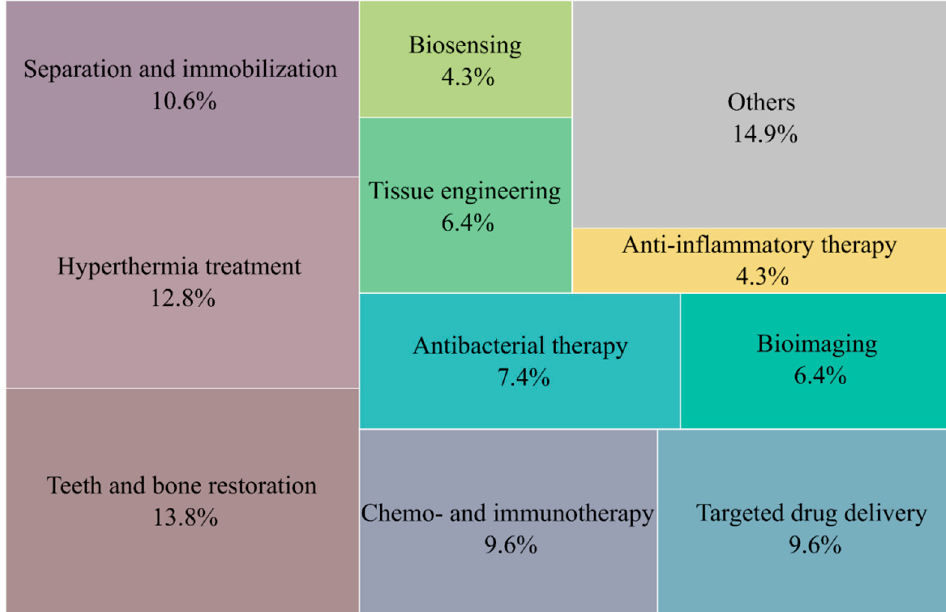
Figure 14. Main applications of biomimetic nanomaterials.